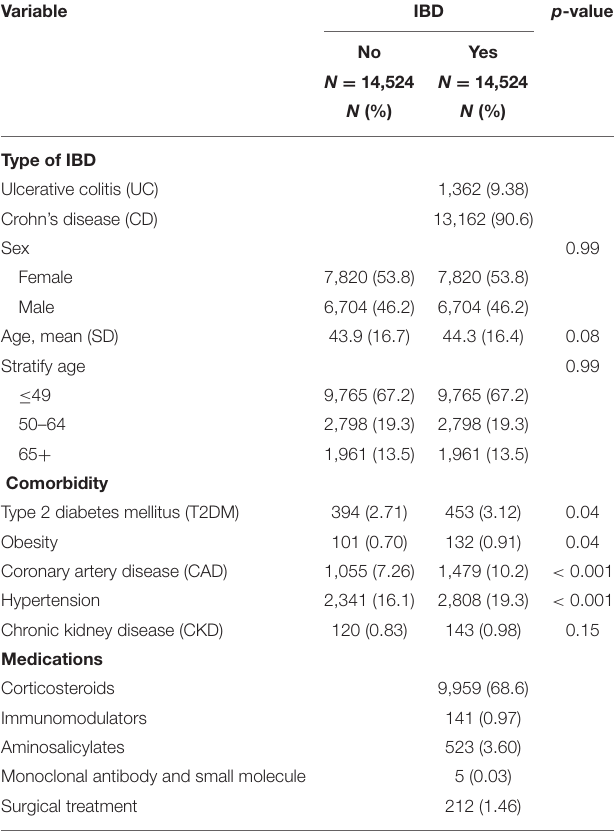
TABLE 2 | Demographic characteristics, comorbidities, and medications in patient with and without inflammatory bowel disease (IBD). Variable